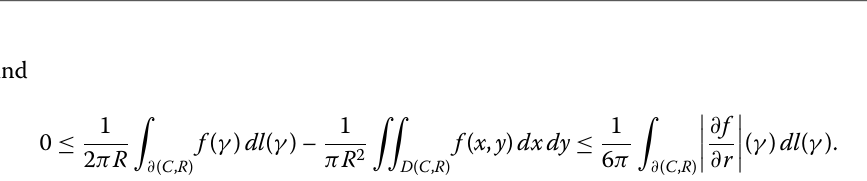
Figure 3 Comparison between the graph of f and the graph of it’s partial derivative with respect to the variable